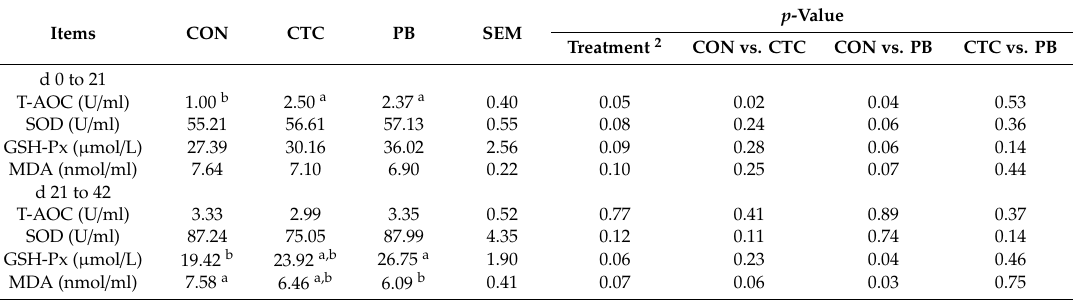
Table 5. E ff ects of probiotics on the serum antioxidant function of broilers 1